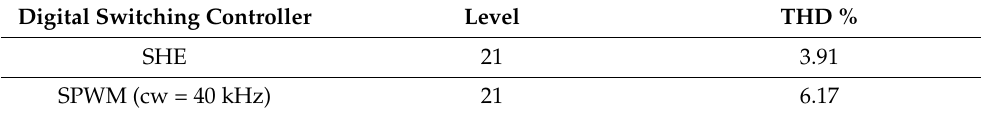
Table 11. THD comparison of 21-level inverters for SHE and SPWM digital switching controllers.